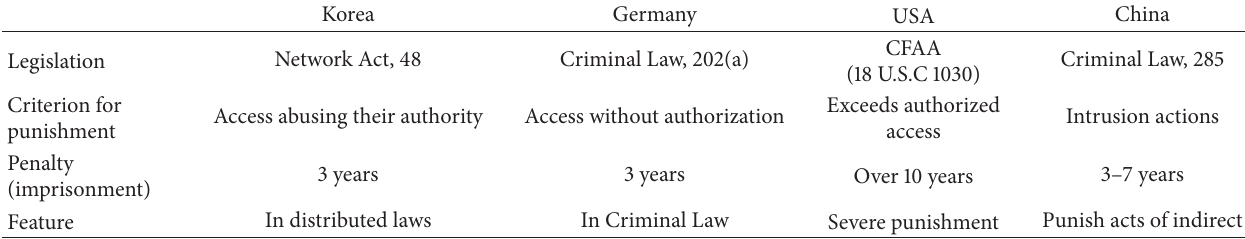
Table 1: Comparing each country’s criminal